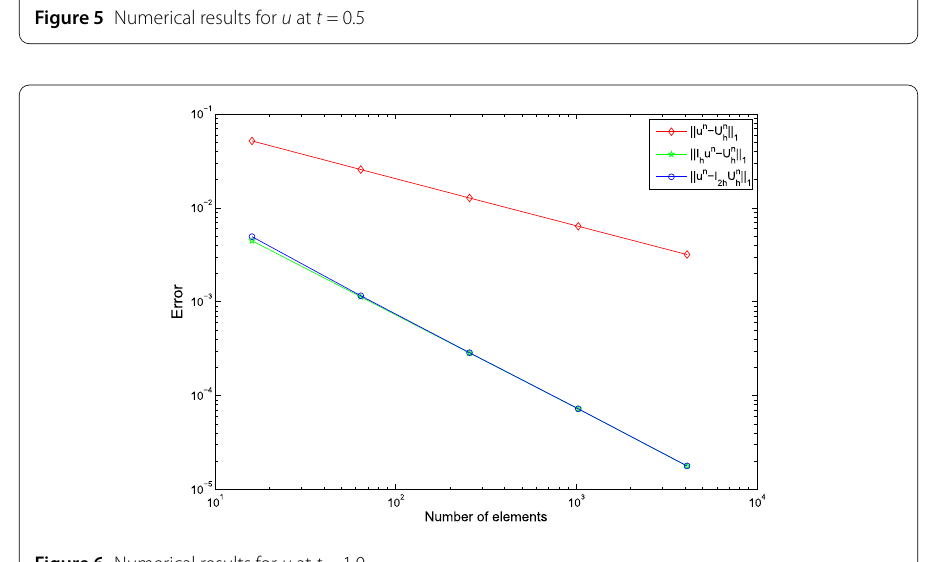
Figure 6 Numerical results for u at t = 1.0